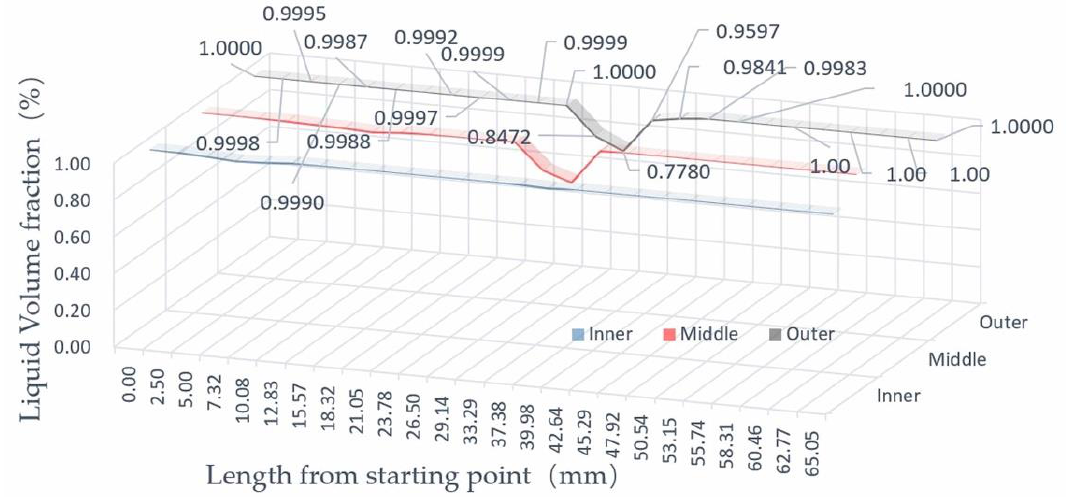
Figure 17. Distribution of liquid components at radial points inside the impeller.